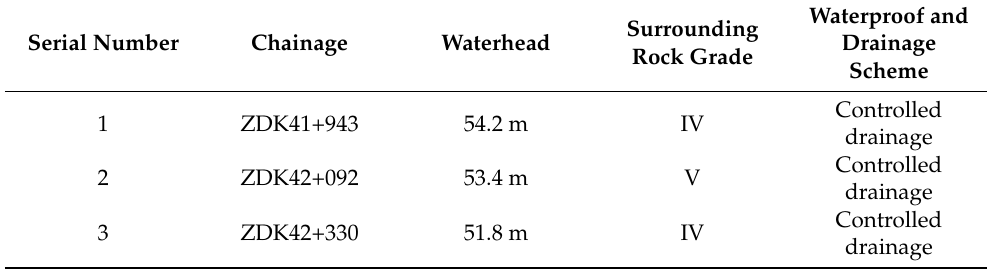
Table 2. The statistics of monitoring sections. Table 3. Physical and mechanical parameters of surrounding rock.